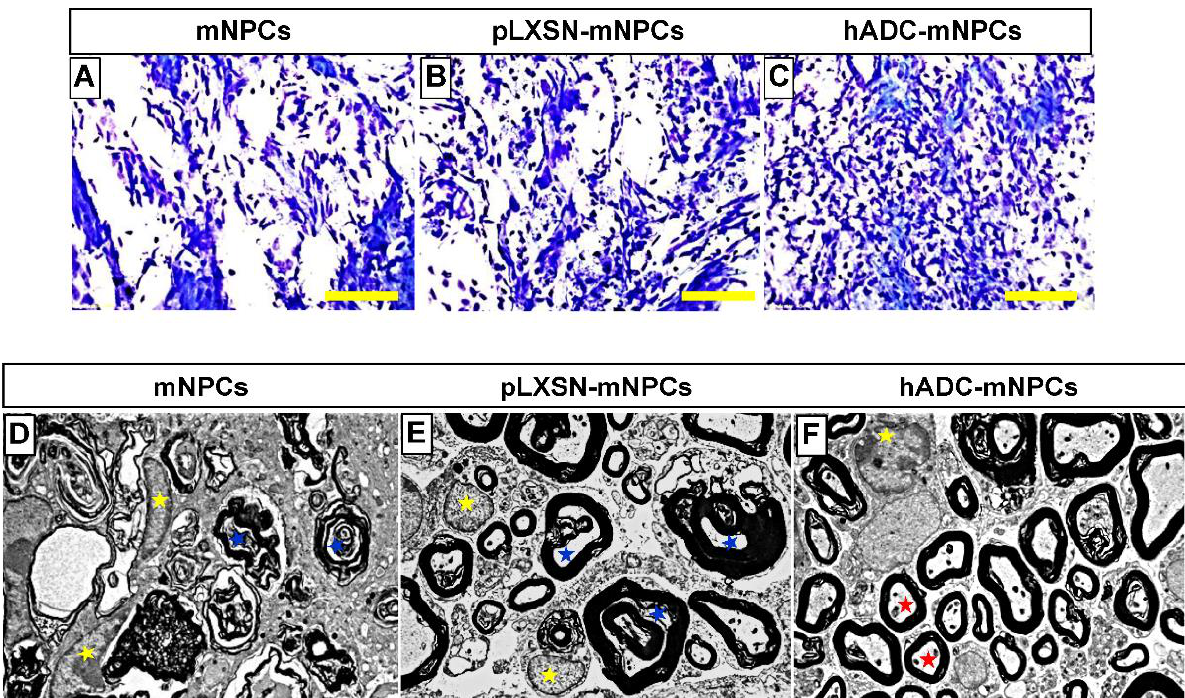
Figure 5. Luxol fast blue staining of T9 spinal cord sections obtained from the mNPC ( A ), pLXSN- mNPC ( B ), and hADC-mNPC ( C ) transplantation groups at 6 weeks after SCI. The hADC-mNPC group ( C ) had smaller cystic cavities and more myelin sheaths than the other two groups ( A and B ). Scale bar = 20 μm. Transmission electron microscopy (TEM, 10,000×) of the lumbar section where mNPCs ( D ), pLXSN-mNPCs ( E ), and hADC-mNPCs ( F ) were transplanted after SCI. Transplanted hADC-mNPCs promoted axon remyelination at the lesion site. Red stars indicate remyelinated or mature axons in the hADC-mNPC group, while blue and yellow stars indicate degenerating myelinated axons and microglia/macrophage cells, respectively.